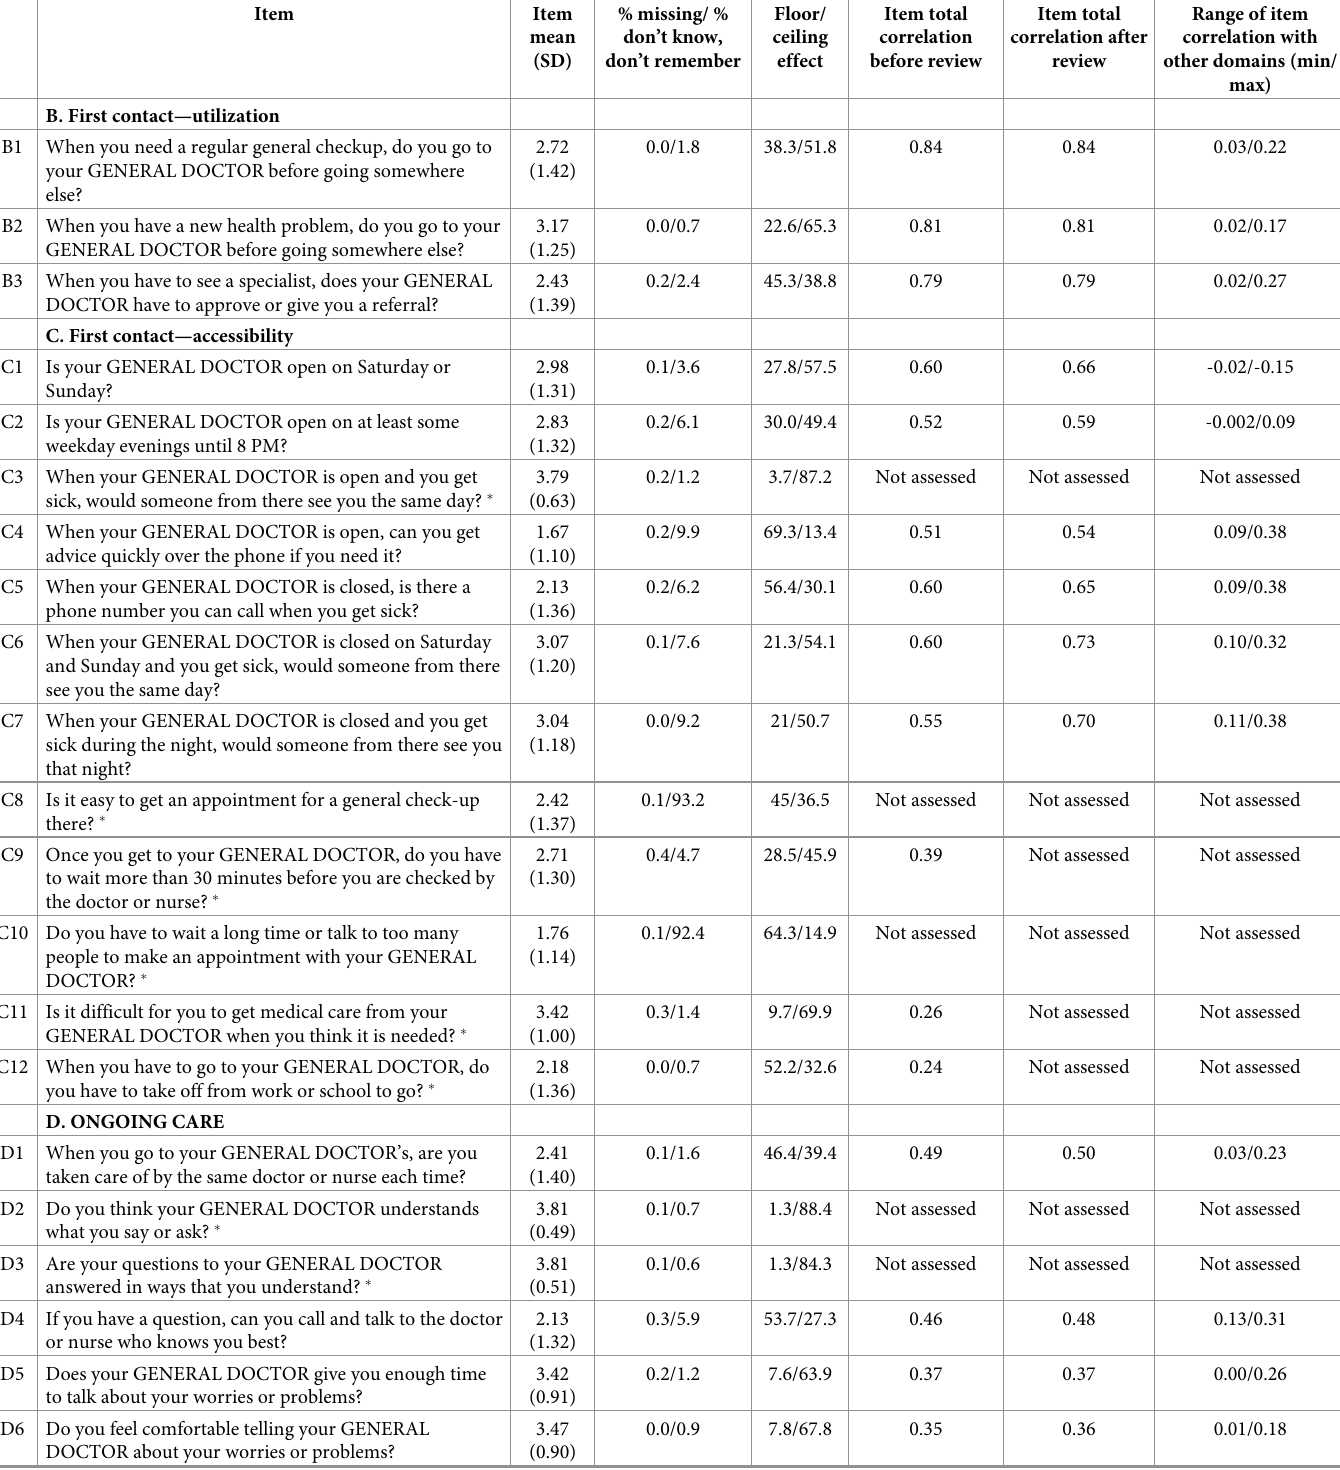
Table 3. Item mean (SD), percentage ‘ don’t know , don’t remember/missing ’,floor/ceiling effect, item total correlation before review, item-total correlation after review and range of item correlation with other